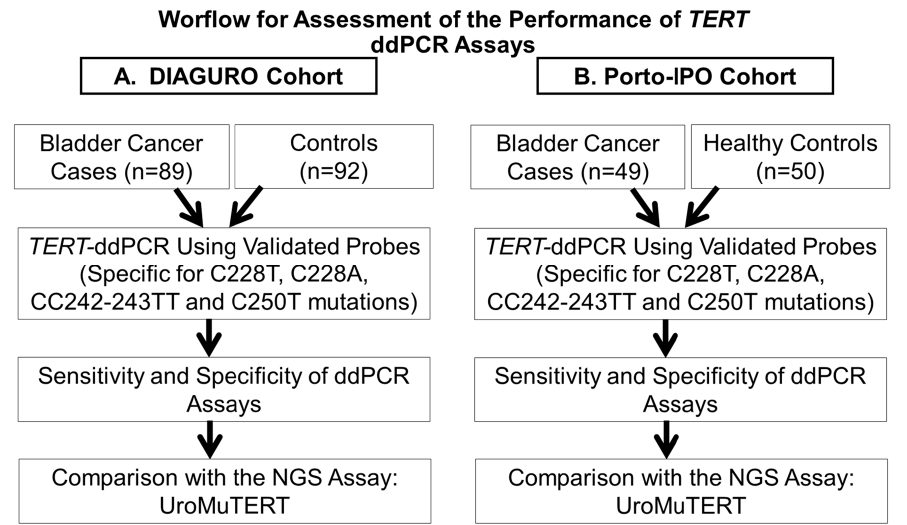
Figure 8. Schematic representation of the workflow for assessing the performance of the